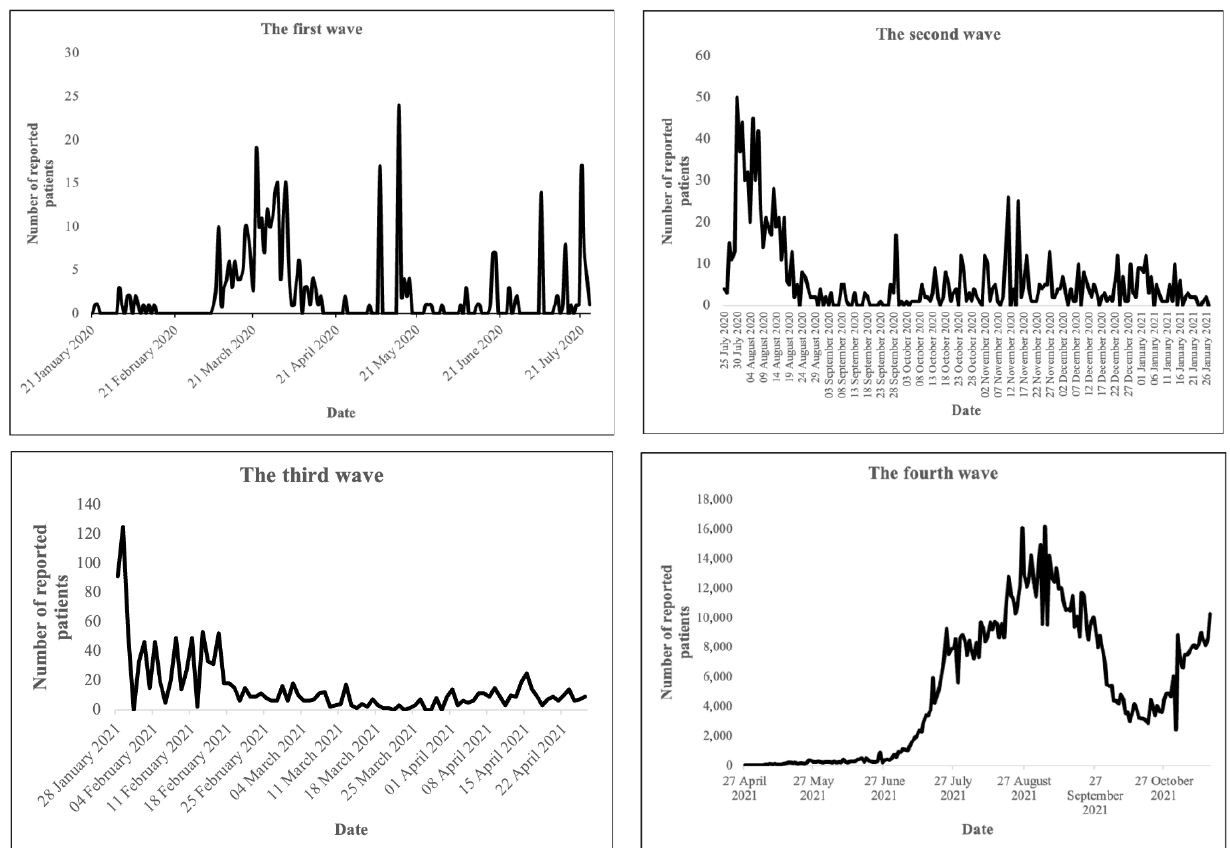
Figure 2. The total number of daily reported cases in four waves of the COVID-19 outbreak in Vi-